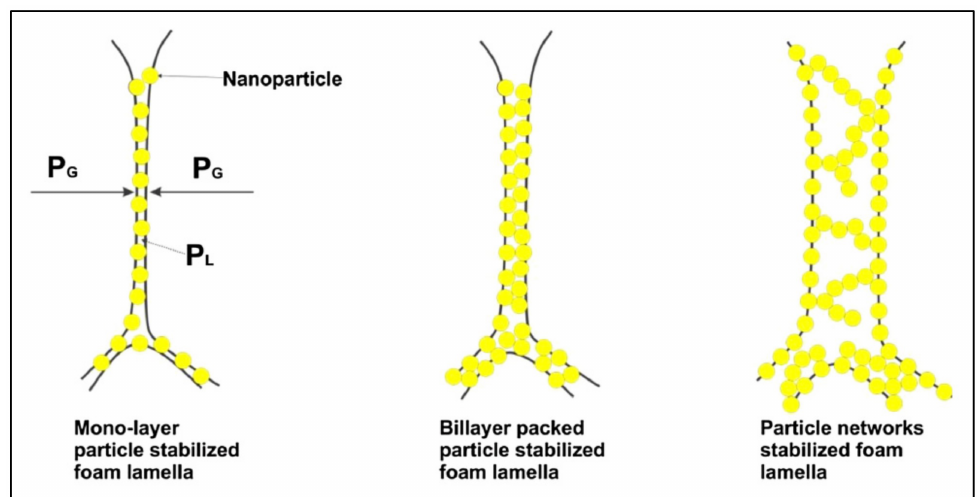
Figure 22. Different arrangements of nanoparticles on foam interface (Fei et al. [4,39]).